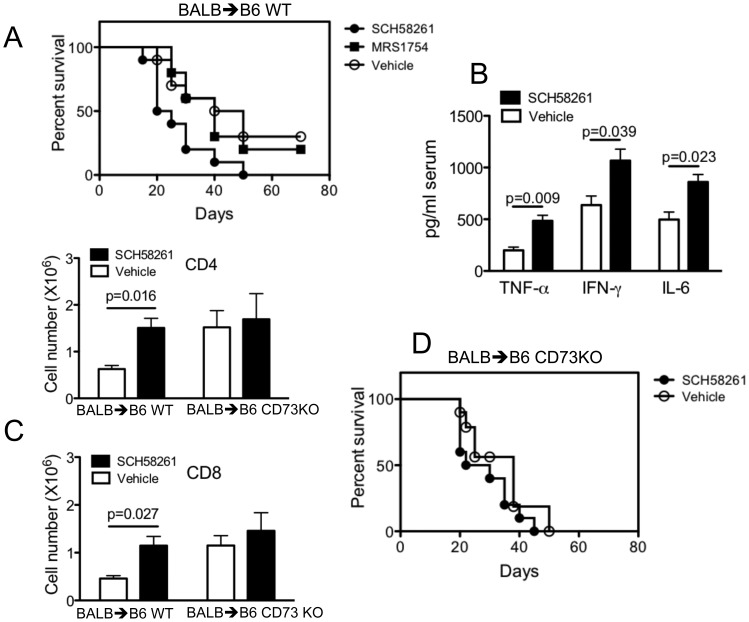
A2AR antagonist administration worsens GVHD.(A) Lethally irradiated B6 mice were given i.v. injections of 5×106 T cell depleted BALB/c BM cells with 2×107 splenocytes. Recipients received daily i.p. injections of 2 mg/kg SCH58261, 2 mg/kg MRS1754 or vehicle (0.1% DMSO). Injections were initiated 48 h before cell transfer and continued for 14 days. SCH58261 versus vehicle, p = 0.0204. (B) Indicated cytokines were measured in recipient serum on day 14 after donor BM and T cell transfer as described above (n = 5). (C) Enriched BALB/c WT T cells were injected i.v. into lethally irradiated B6 WT or CD73 KO mice at 2×106 per mouse, and cell expansion was determined 14 days after cell transfer. Recipients received daily i.p. injections of 2 mg/kg SCH58261 or vehicle (0.1% DMSO) as described above. Mean of absolute numbers of CD4+ or CD8+ cells per spleen was shown in recipients given donor T cells (n = 5). (D) Lethally irradiated B6 CD73 KO mice were given i.v. injections of 5×106 T cell-depleted BALB/c BM cells with 2×107 splenocytes. Recipients received daily i.p. injections of 2 mg/kg SCH58261 or vehicle (0.1% DMSO) as described above.